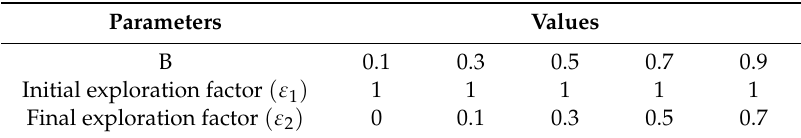
Table 4. Values of B, ε 1 , ε 2 for making input